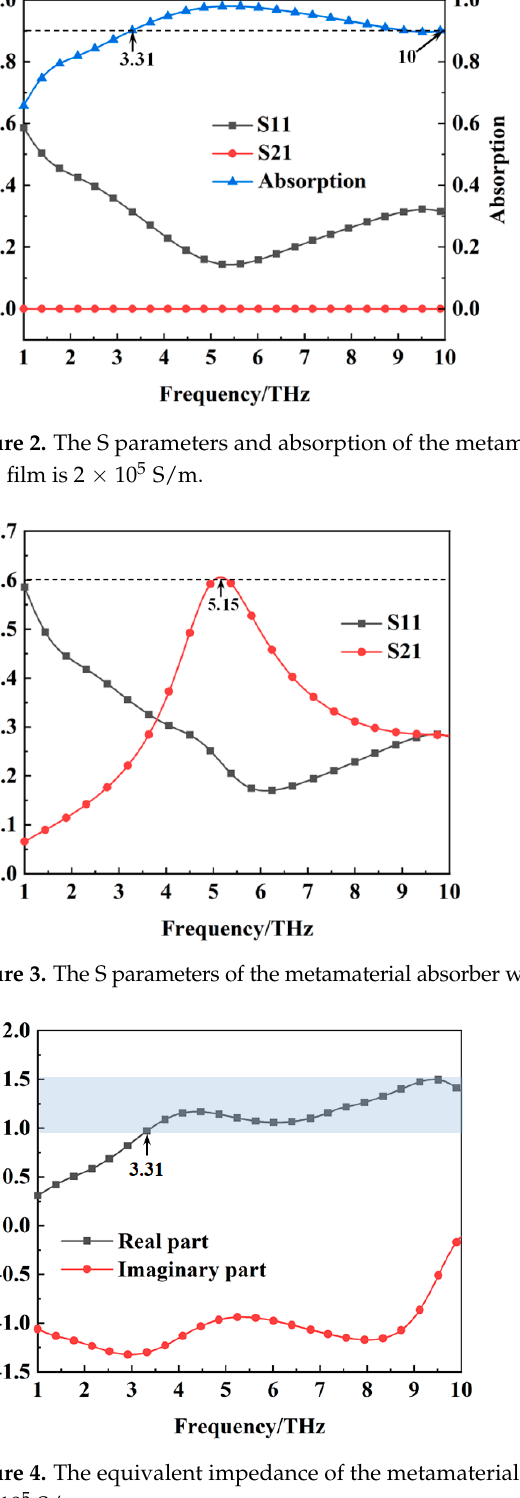
Figure 4. The equivalent impedance of the metamaterial absorber when the conductivity of VO 2 is 2 × 10 5 S/m.